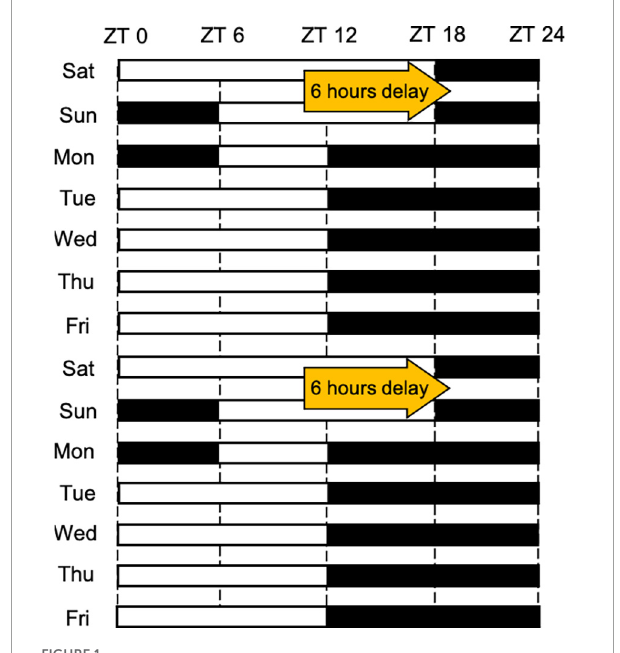
FIGURE1 The light schedule followed under conditions mimicking SJL. The white and black bars reflect the on and off status of the light,